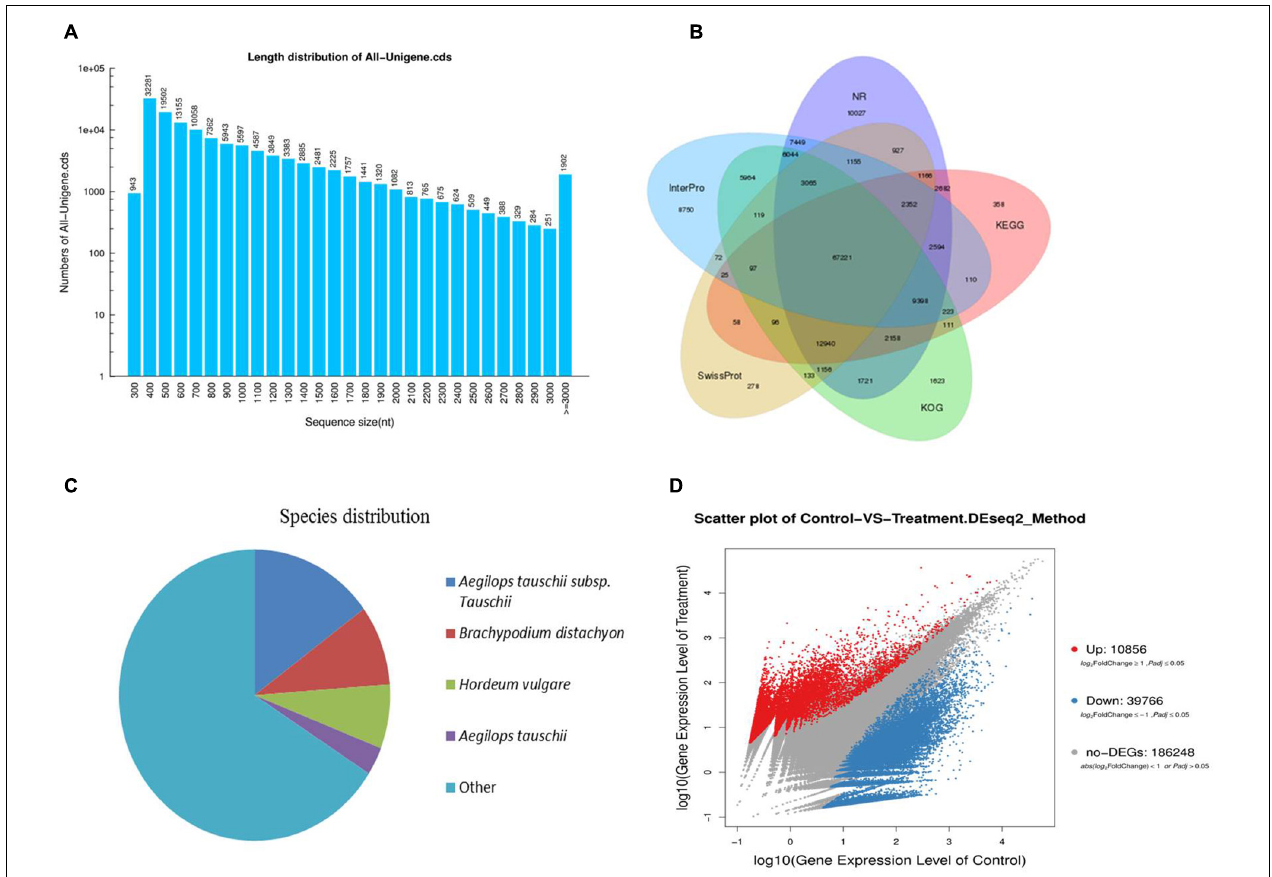
FIGURE 2 | The length distribution of unigenes of Puccinellia nuttalliana transcriptome (A) , venn diagram showing functional annotation between NR, KOG, KEGG, Swissprot, and Interpro databases (B) , distribution and frequency of non-redundant (NR) annotated species (C) , scatter plot of differentially expressed genes (DEGs) in roots of NaCl-treated Puccinellia nuttalliana plants compared to the controls. Red color represents the up-regulated genes, blue color represents the down-regulated genes, gray color represents the non-significant differential genes (D)